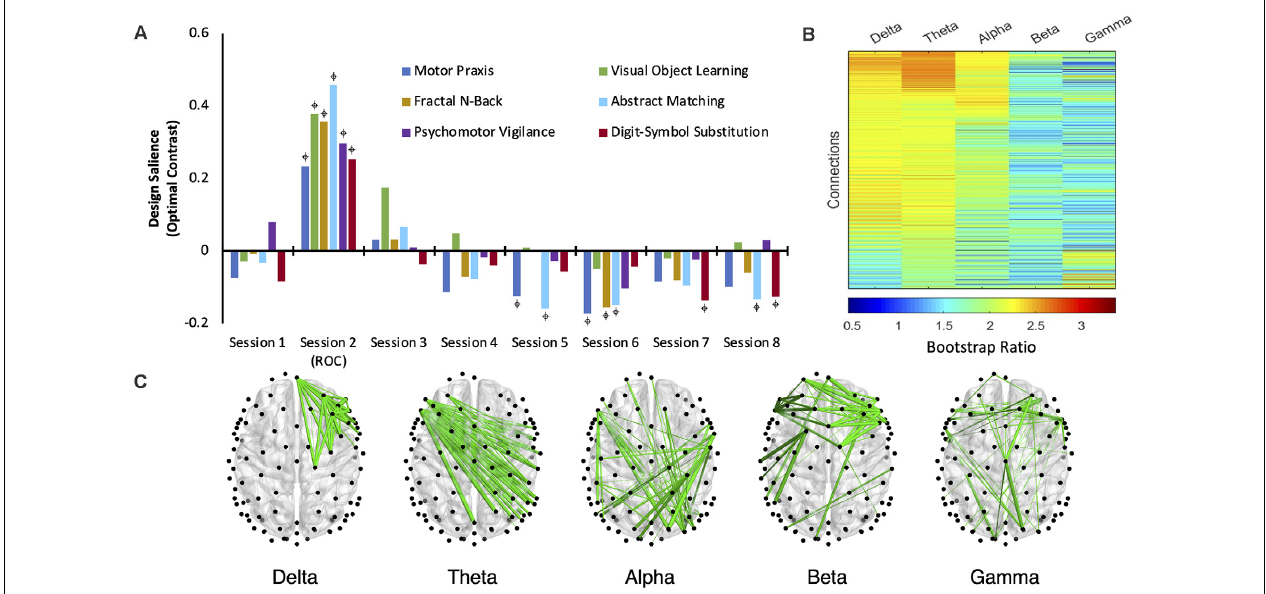
FIGURE 4 | The dominant latent variable (LV = 1) capturing the network of maximal functional connectivity covariance across the anesthetic protocol (five frequency bands, eight cognitive testing sessions, consisting of six cognitive tasks; PLS analysis, variation 2). (A) Permutation testing identified a significant design salience (optimal contrast) that captured a session × task interaction depicting the maximal covariance of function related to the recovery of cognitive function after anesthetic-induced unconsciousness ( p < 0.0005) with an attributable proportion of cross block covariance (ES) of 74%. ⌖ = non-zero bootstrap-estimated 95% confidence interval. (B) Bootstrap ratios (BSRs) for each connection (pair of electrodes) associated with each frequency band. The higher the BSR magnitude, the more reliably the connection expressed the contrast in its present orientation (see “Materials and Methods” section). (C) The top 1% of connections that reliably express the contrast, determined by thresholding the BSRs.